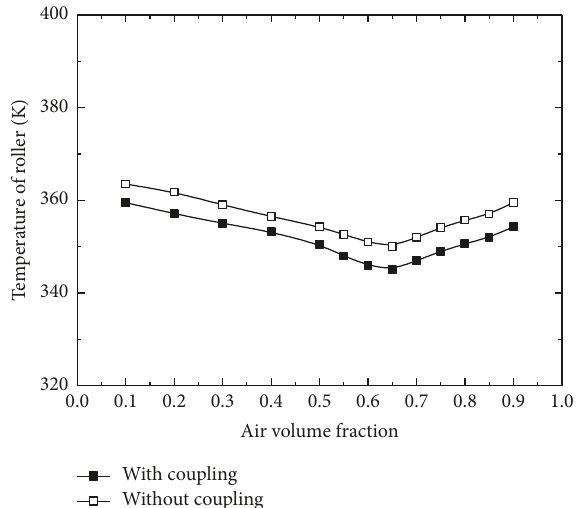
Figure 11: Relation of maximum roller temperature and air volume fraction at 5000 rpm.